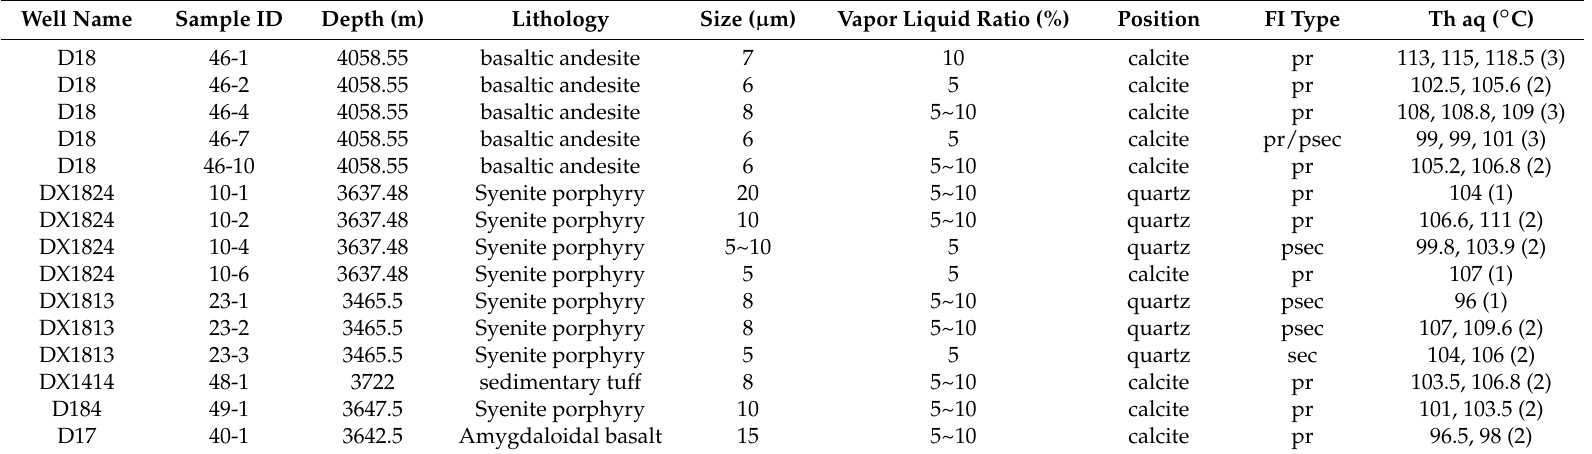
Table 3. Fluid inclusion homogenization temperature (Th) of the Carboniferous igneous reservoirs in the Dixi Area.